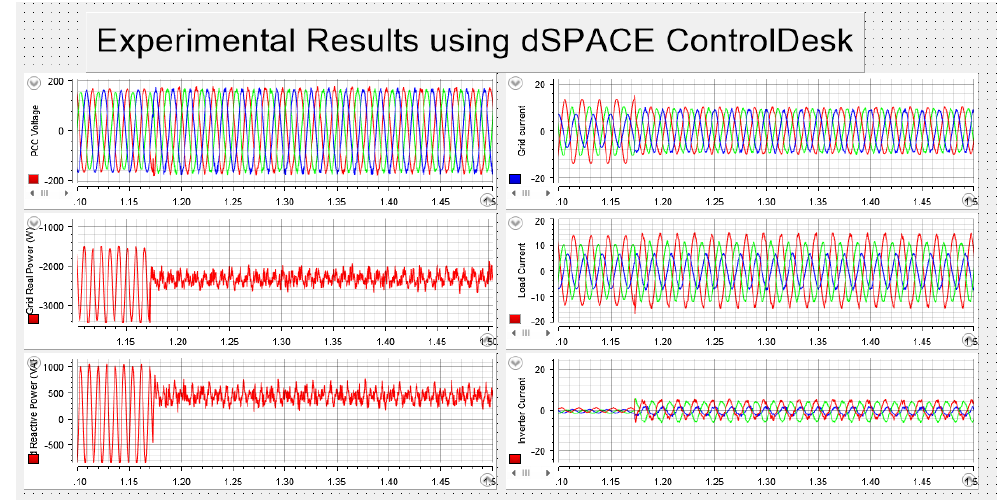
Figure 11. Experimental results for shunt APF working mode, using dSPACE Control desk.